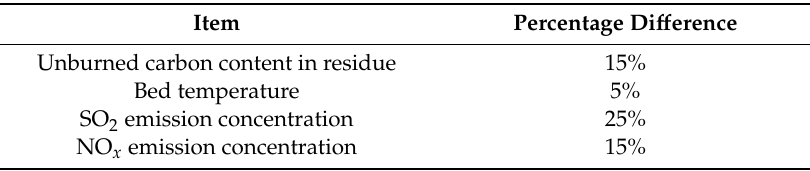
Table 4. Di ff erence between calculated and experimental